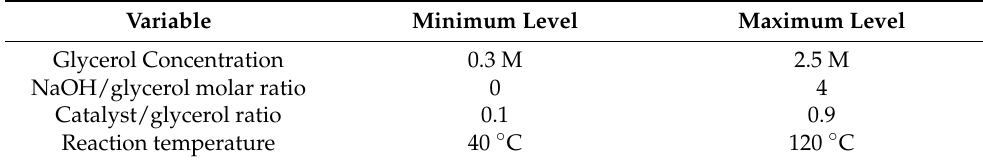
Table 3. Variables of study in the central composite design (CCD)